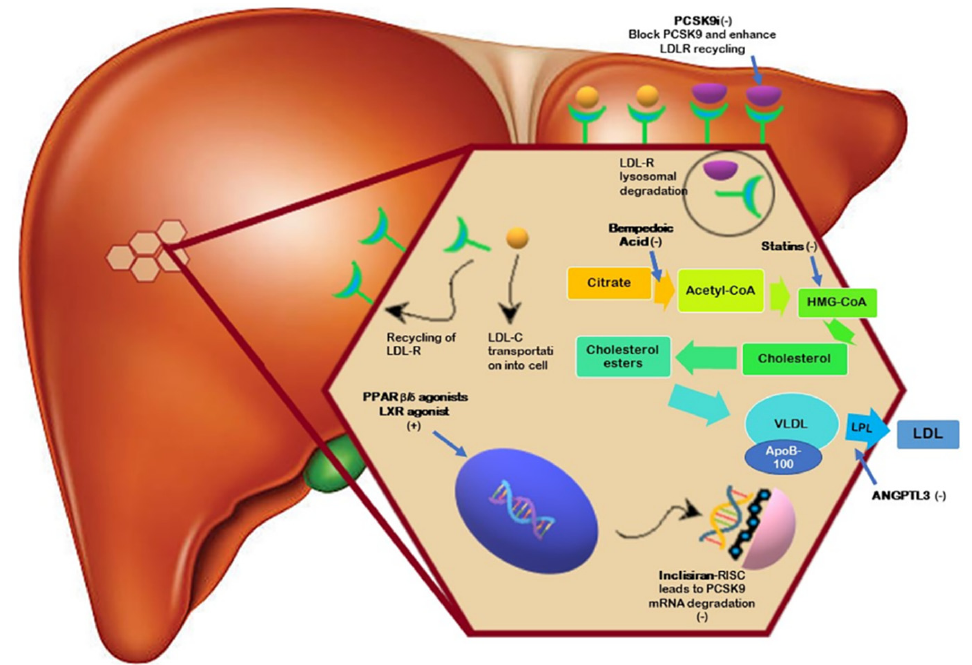
Figure 1. Mechanism of action of novel lipid-lowering drugs used for the treatment of non-familial hypercholesterolemia (non-FH).